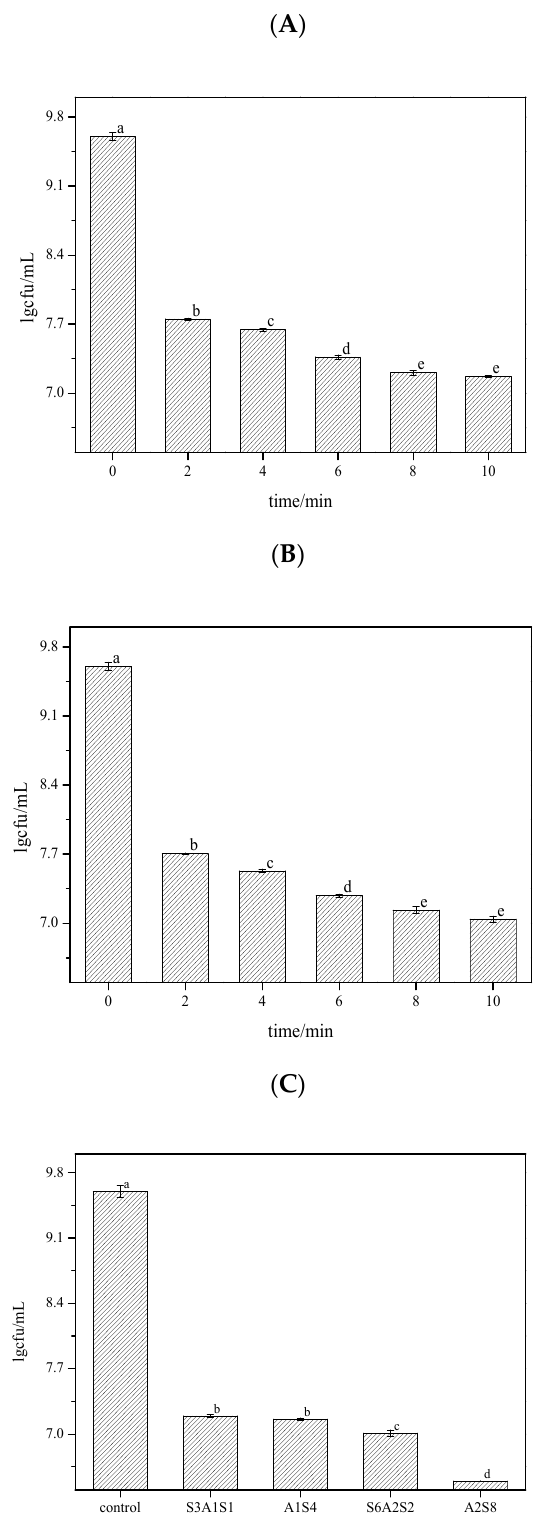
Figure 1. The bactericidal rate of each treatment was determined by the coated plate method after treating LM biofilm with three groups of bactericides for different times. The different letters indicate significant differences ( p < 0.05). Data were expressed by mean measurements ± standard devi- ation (SD), and all treatments and determinations were performed in triplicate. ( A ) is the bactericidal rate of SAEW. ( B ) is the bactericidal rate of NEHW. ( C ) is the bactericidal rate of AEW and ALEW. SAEW was the abbreviation of slightly acidic electrolytic water, and NEHW was the abbreviation of non-electrolytic hypochlorite water. In A 1 S 4 , A 2 S 8 , S 3 A 1 S 1 , and S 6 A 2 S 2 treatment, S stands for